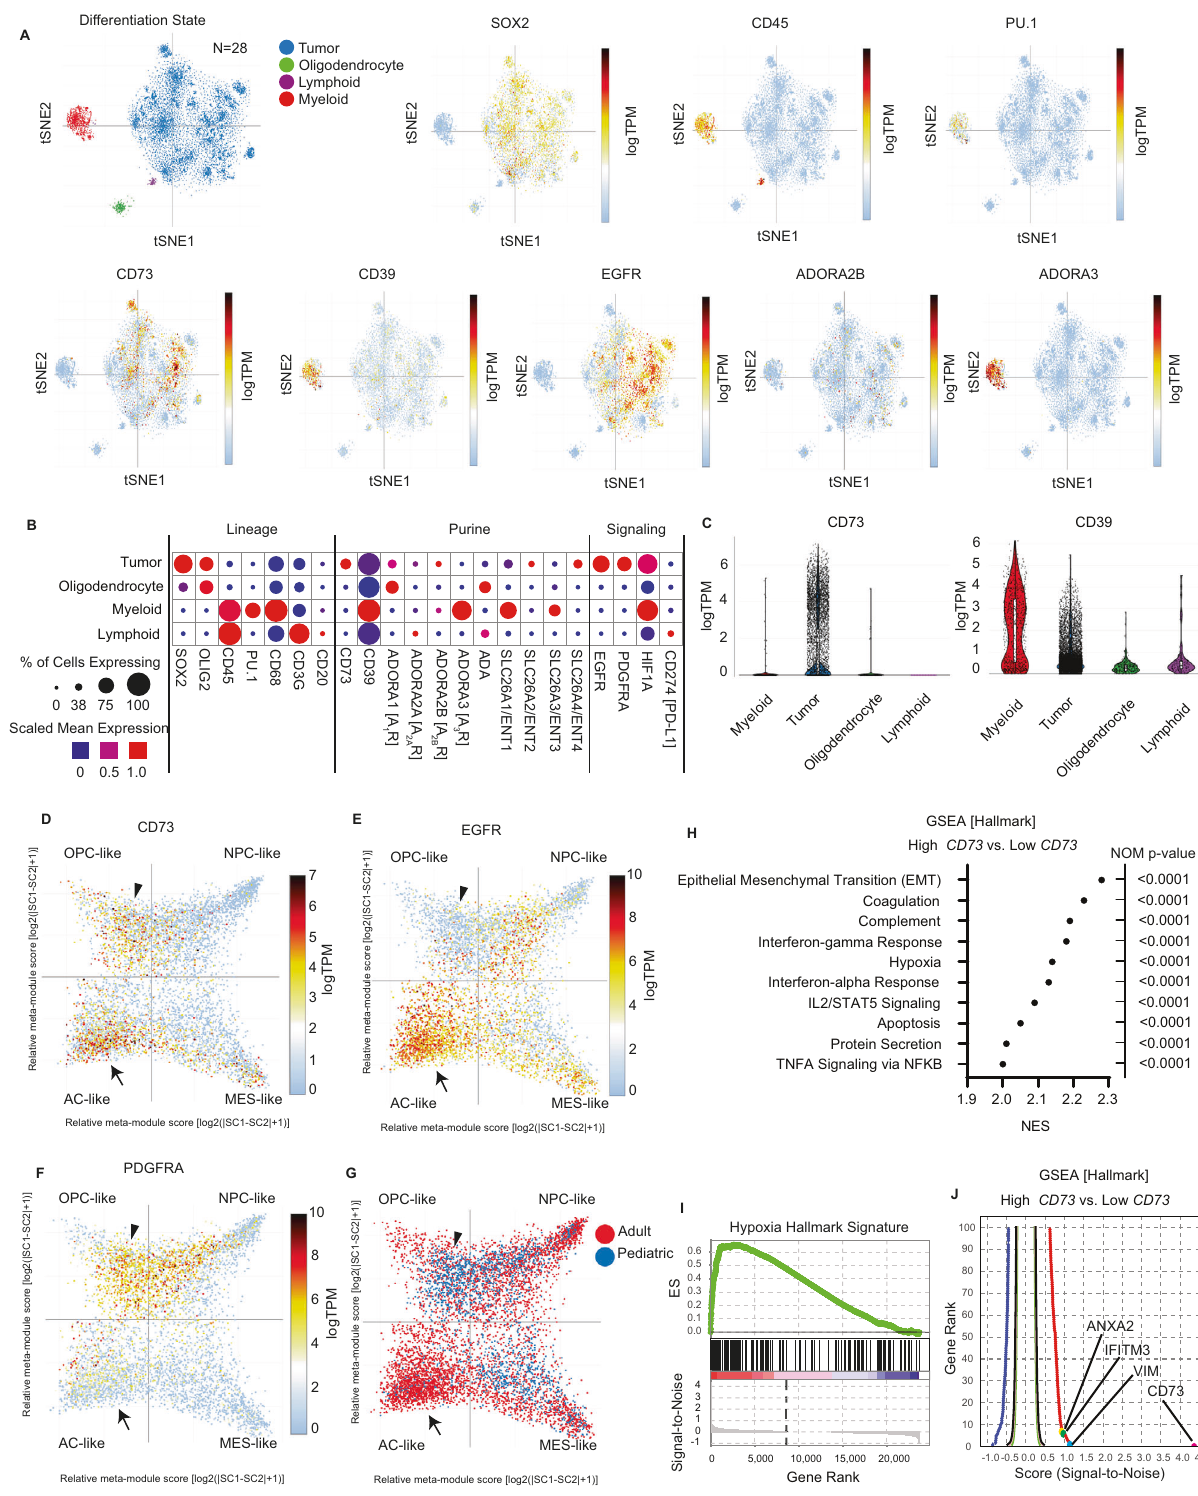
Lineage Purine Tumor Oligodendrocyte Myeloid Lymphoid 75% of Cells Expressing Expression0 38 100 1.0Scaled Mean 0 0.5